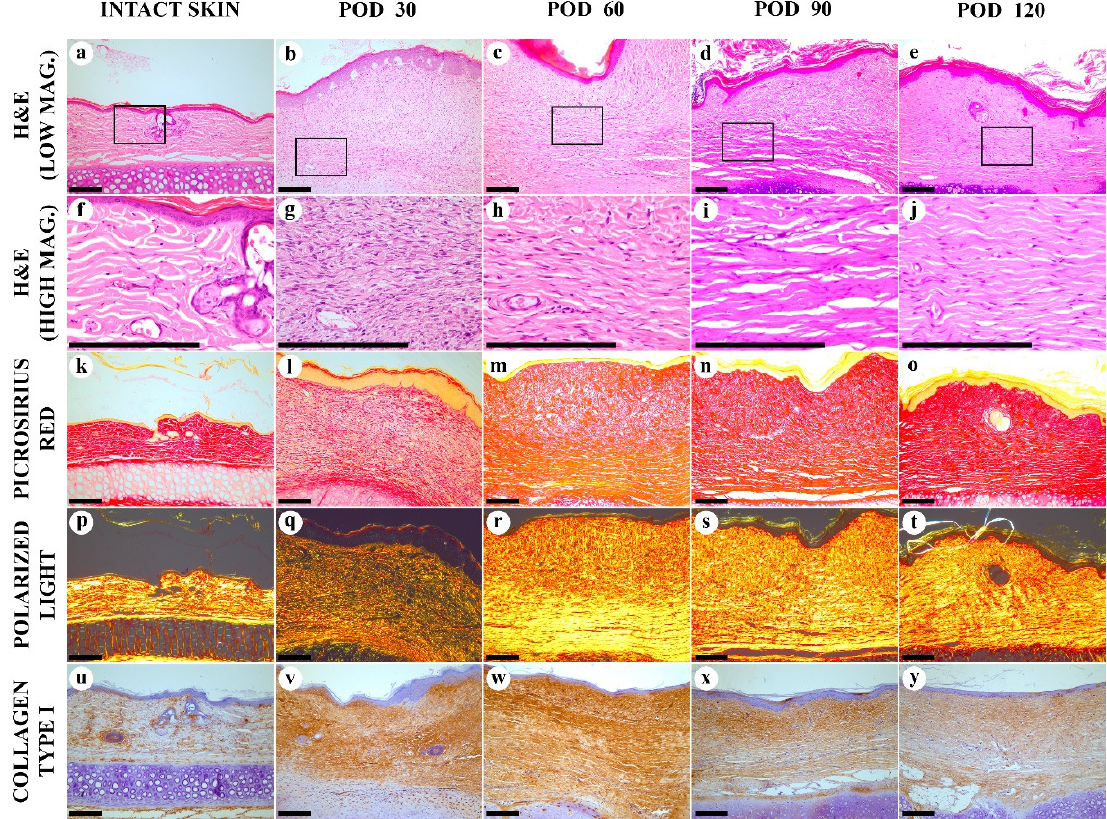
Figure 2. Histological examination of the intact skin and experimental scars. ( a – j ) hematoxylin and eosin (H&E) staining; ( k – t ) Picrosirius red (PSR) staining; ( u – y ) immunohistochemistry (IHC) staining for collagen type I. Columns depict the studied groups (intact skin and experimental scars on PODs 30, 60. 90 and 120). Images were taken in bright-field ( a – o , u – y ) or polarized light ( p – t ) illumination. Scale bars are 200 μ m.